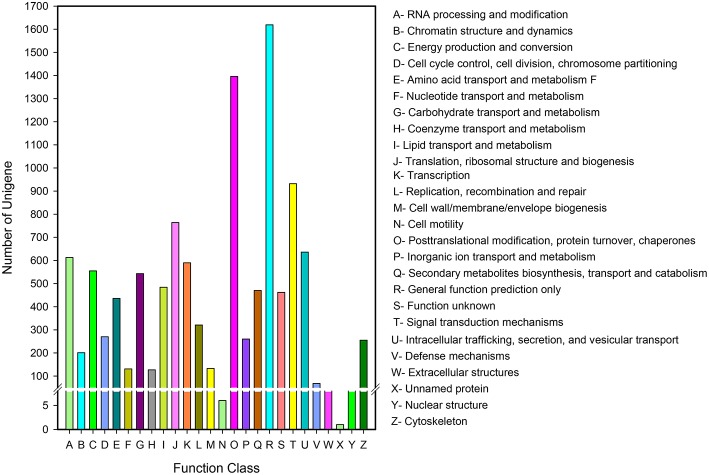
KOG function classification of D. asperoides. All the unigenes were aligned to the KOG database to predict and classify possible functions. A total of 10,056 unigenes were clustered into functional orthologs.